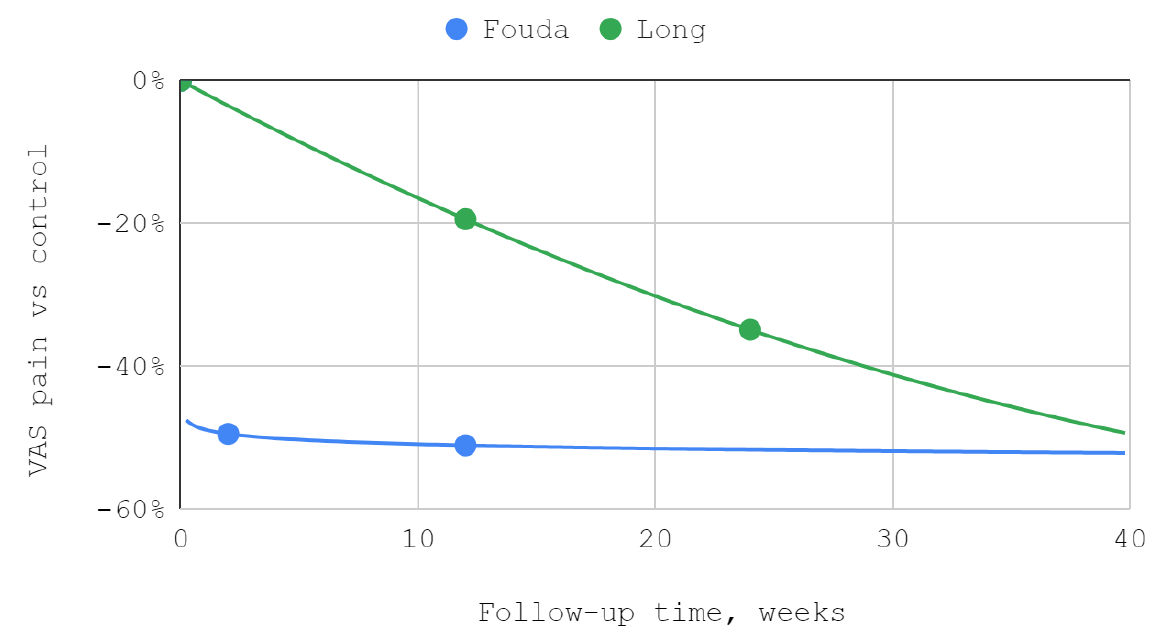
Figure 7. The efficiency of inferior versus superior compartment TMJ treatment in VAS articular pain domain over time.